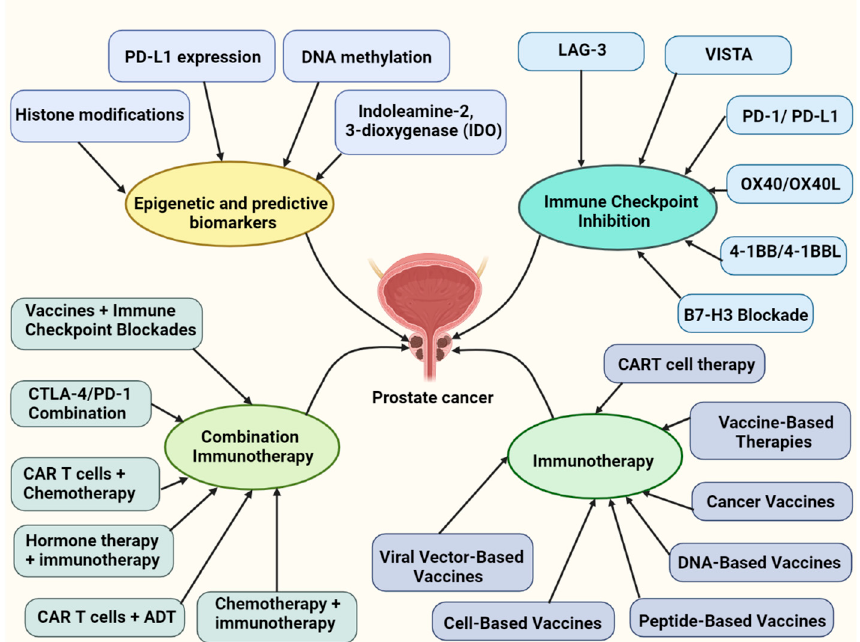
Figure 2. This figure overviews the epigenetic and predictive biomarkers, various immune check- point inhibitors, immunotherapies, and combination immunotherapeutic approaches implicated in prostate cancer.